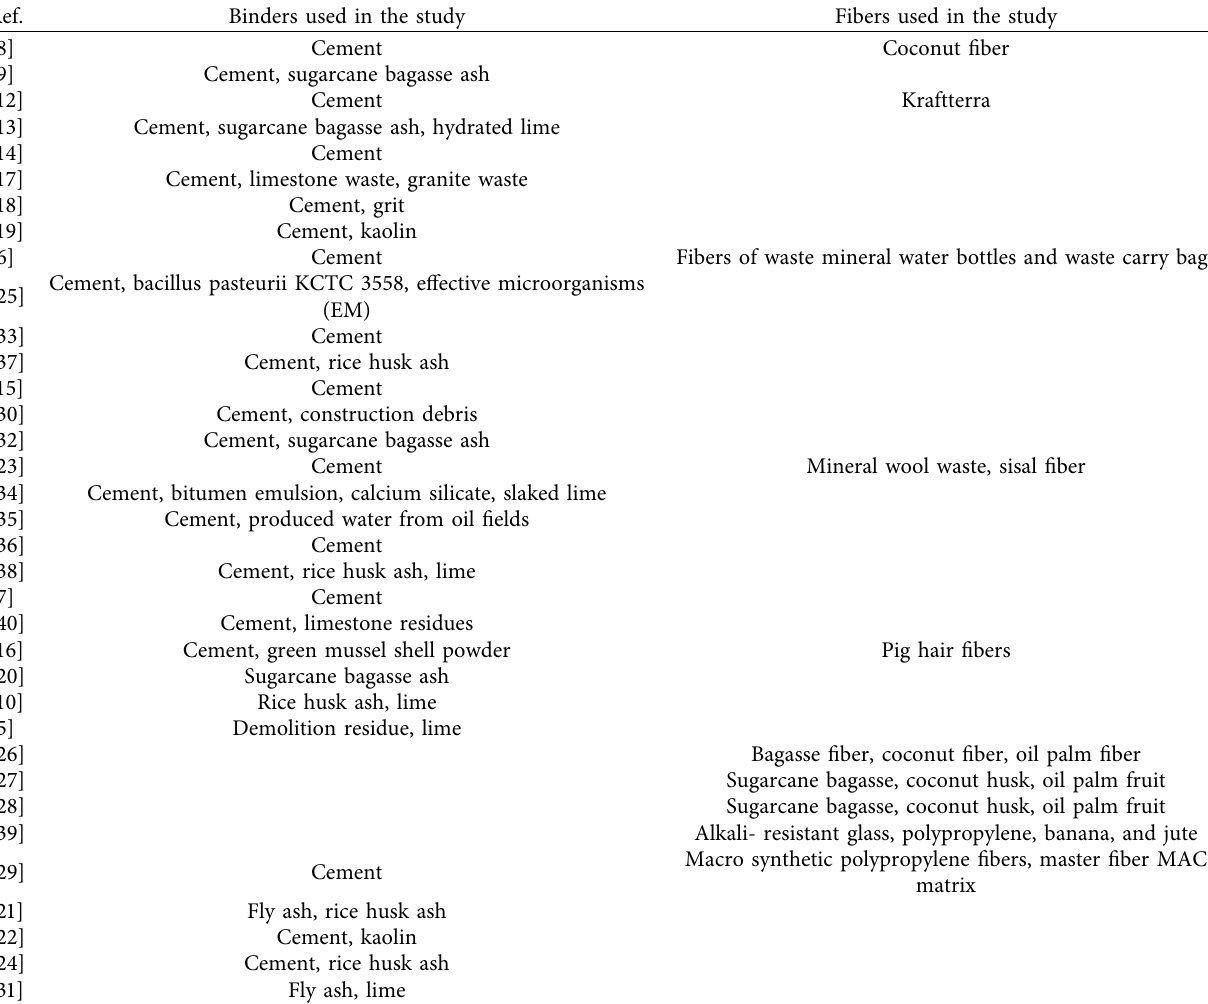
Table 4: Binders and fibers used for making unfired admixed soil blocks in published papers ( n � 36).